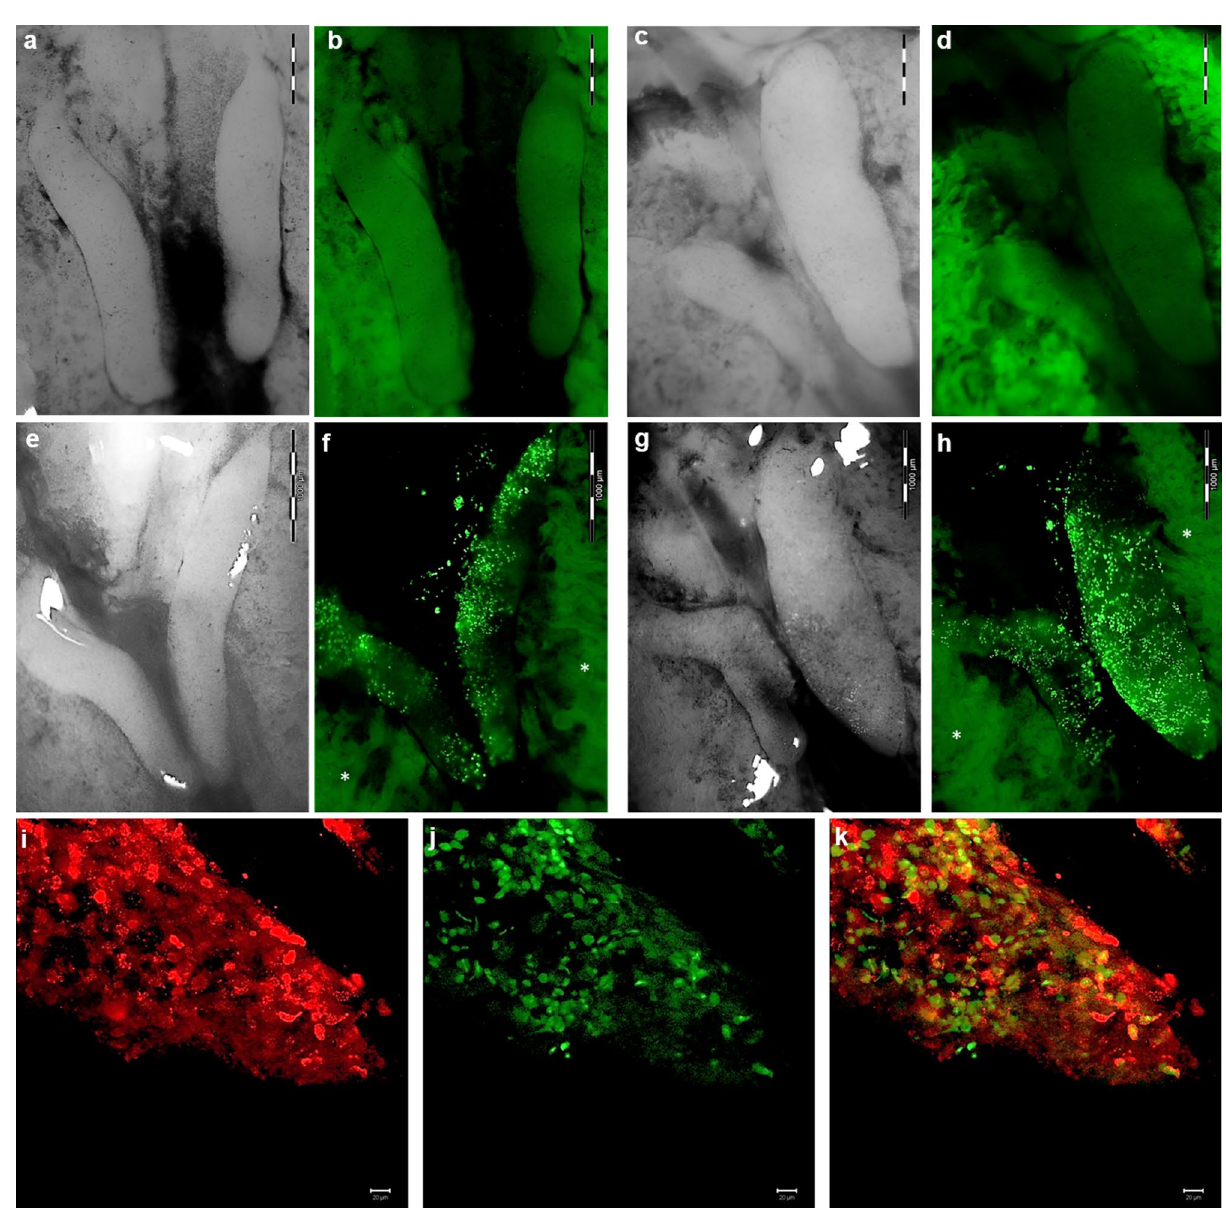
Figure 3. Venus reporter transgenic PGCs in chicken gonads at day 10 of embryonic development. ( a ) Microscopic image of male gonads (Brightfield); ( b ) autofluorescence of male gonads and mesonephros (wildtype, Venus-negative); ( c ) microscopic image of female gonads (Brightfield); ( d ) autofluorescence of male gonads and mesonephros (wildtype, Venus-negative); ( e ) microscopic image of male gonads (Brightfield); ( f ) green fluorescence of male gonads; ( g ) microscopic image of female gonads (ovary and rudimentary right ovary); ( h ) green fluorescence of female gonads; ( i ) immunofluorescence of SSEA-1 in male gonad; ( j ) Venus- fluorescence of PGCs in the colonized male gonad; ( k ) co-expression of SSEA-1 and Venus-protein in PGCs in a male gonad (Merge). *Autofluorescence of the mesonephros, ( a – h : scale bar: 1000 µm; l – k : scale bar: 20